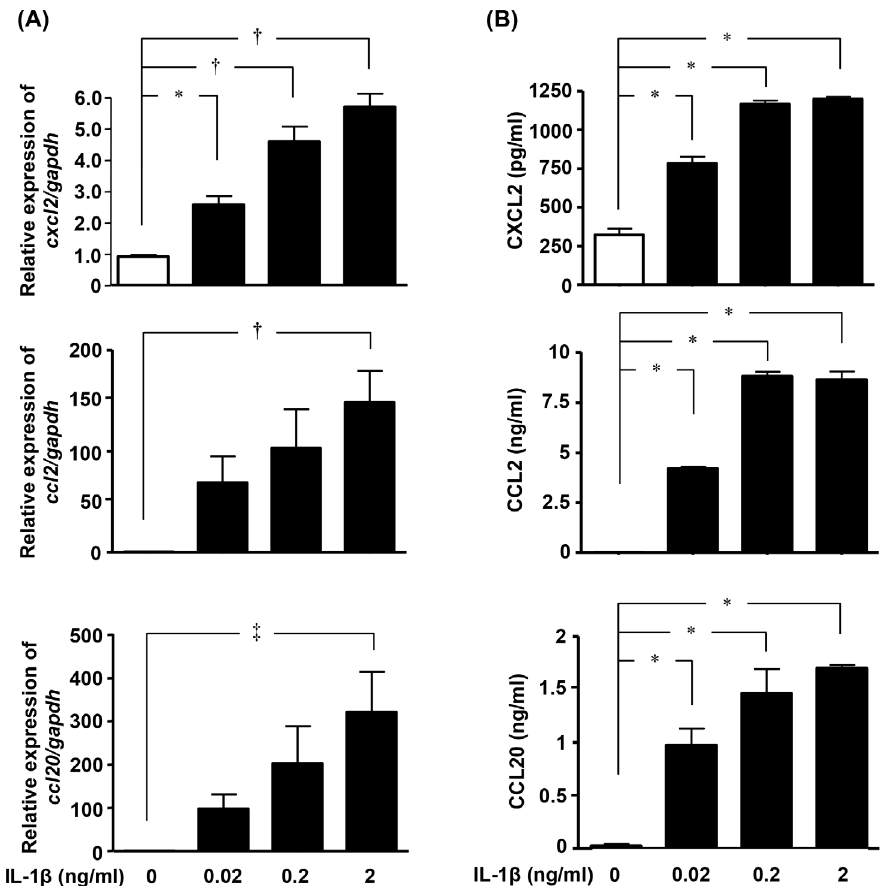
Figure 5. IL-1 b upregulates production of pro-inflammatory chemokines in astrocytes. (A) Cxcl2 , Ccl2 , and Ccl20 mRNA levels in astrocytes, determined by qPCR. Astrocytes were treated with IL-1 b for 6 h. Values are means 6 SEM (n=5). *, p , 0.05; { , p , 0.01. (B) Protein levels of CXCL2, CCL2, and CCL20 in astrocytes, determined by ELISA. Astrocytes were treated with IL-1 b for 24 h. Values are means 6 SEM (n=5). *, p , 0.001.